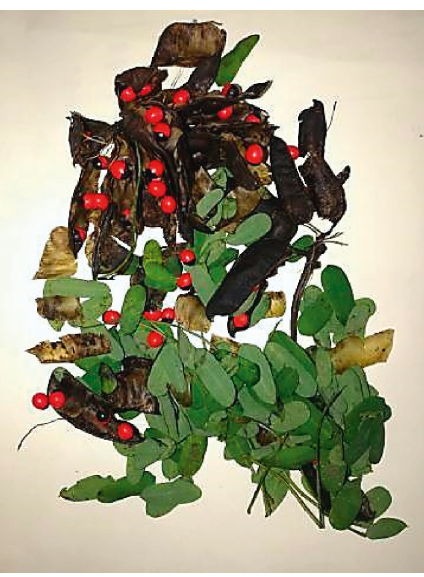
Figure 1: A. precatarius pod with seeds.